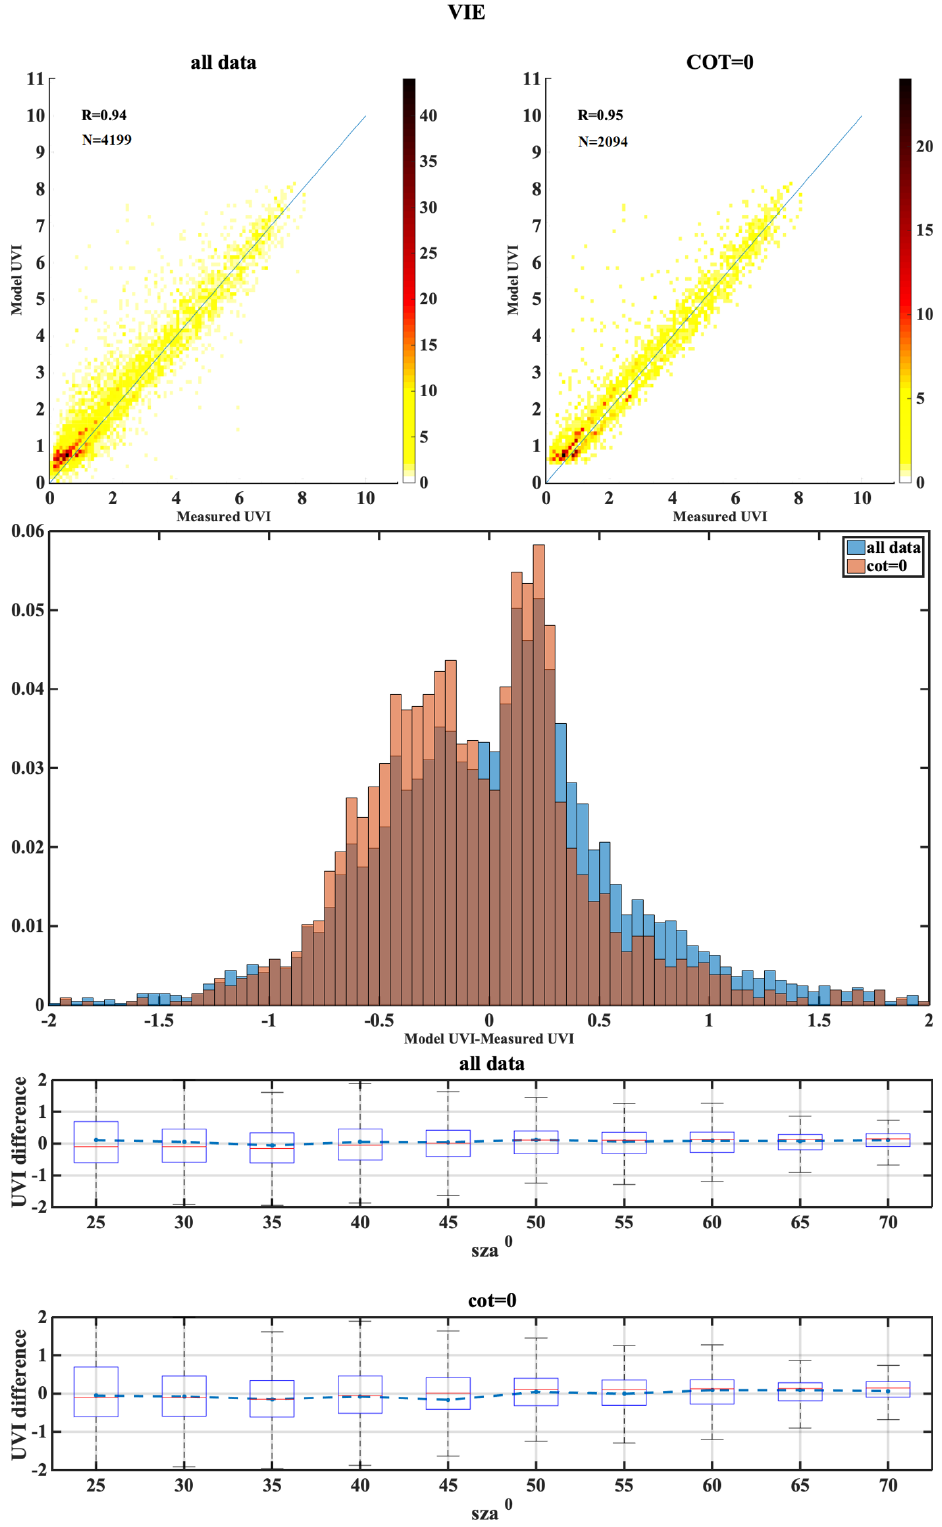
Figure A17. Same as above but for the VIE